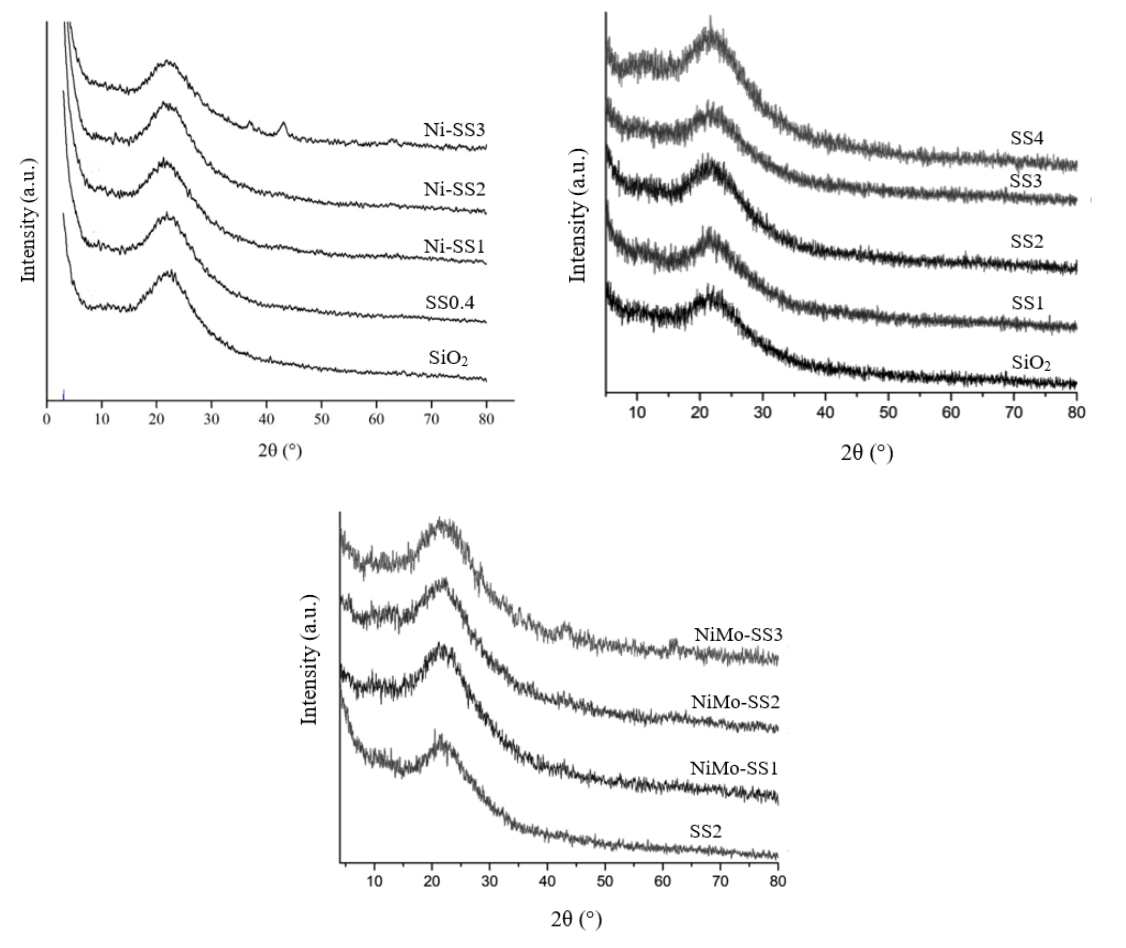
Figure 2. XRD pattern of all catalysts.